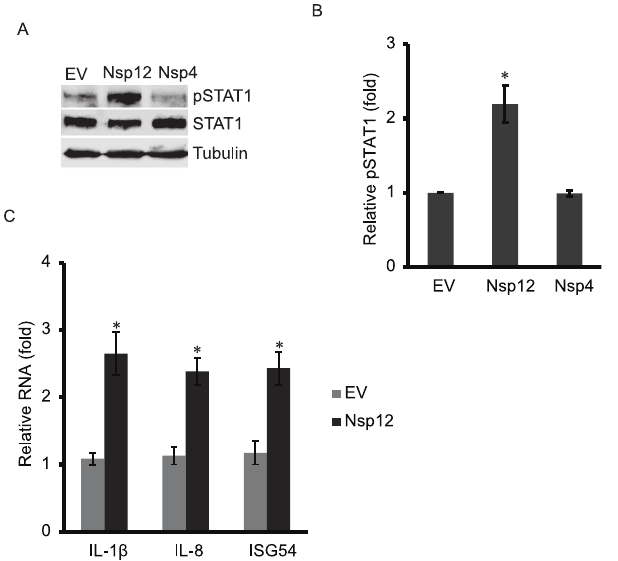
Figure 8. Nsp12 induces elevation of pSTAT1-S727 and expression of proinflammatory genes in HEK293 cells. A. Nsp12 induces elevation of pSTAT1-S727 in HEK293 cells. The cells were transfected with nsp12 or nps4 plasmids. The cells were harvested 48 h after transfection for Western blotting with antibodies against pSTAT1-S727, STAT1 and tubulin. B. Densitometry analysis showing relative pSTAT1 levels in comparison with empty vector lane after normalization with tubulin. C. Nsp12 induces expression of proin- flammatory cytokine genes. HEK293 cells were transfected with nsp12 plasmid and harvested for RT-qPCR. Significant differences between cells transfected with nsp12 and those with empty vector are shown by ‘‘*’’, which indicates P , 0.05.